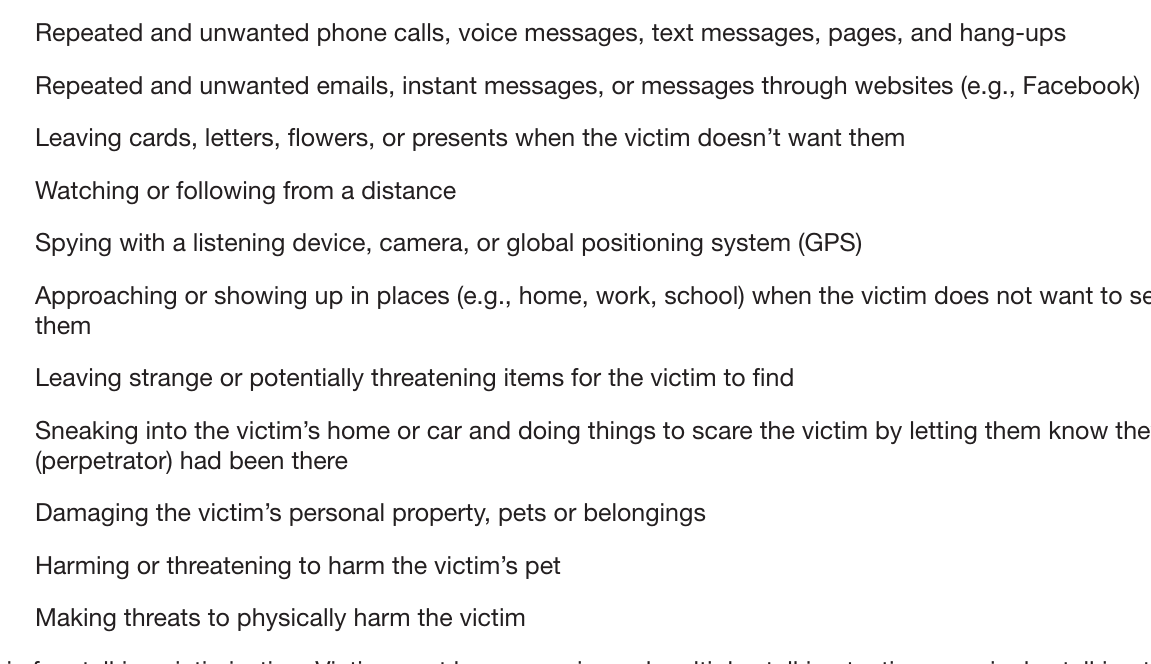
INTIMATE PARTNER VIOLENCE: UNIFORM DEFINITIONS AND RECOMMENDED DATA